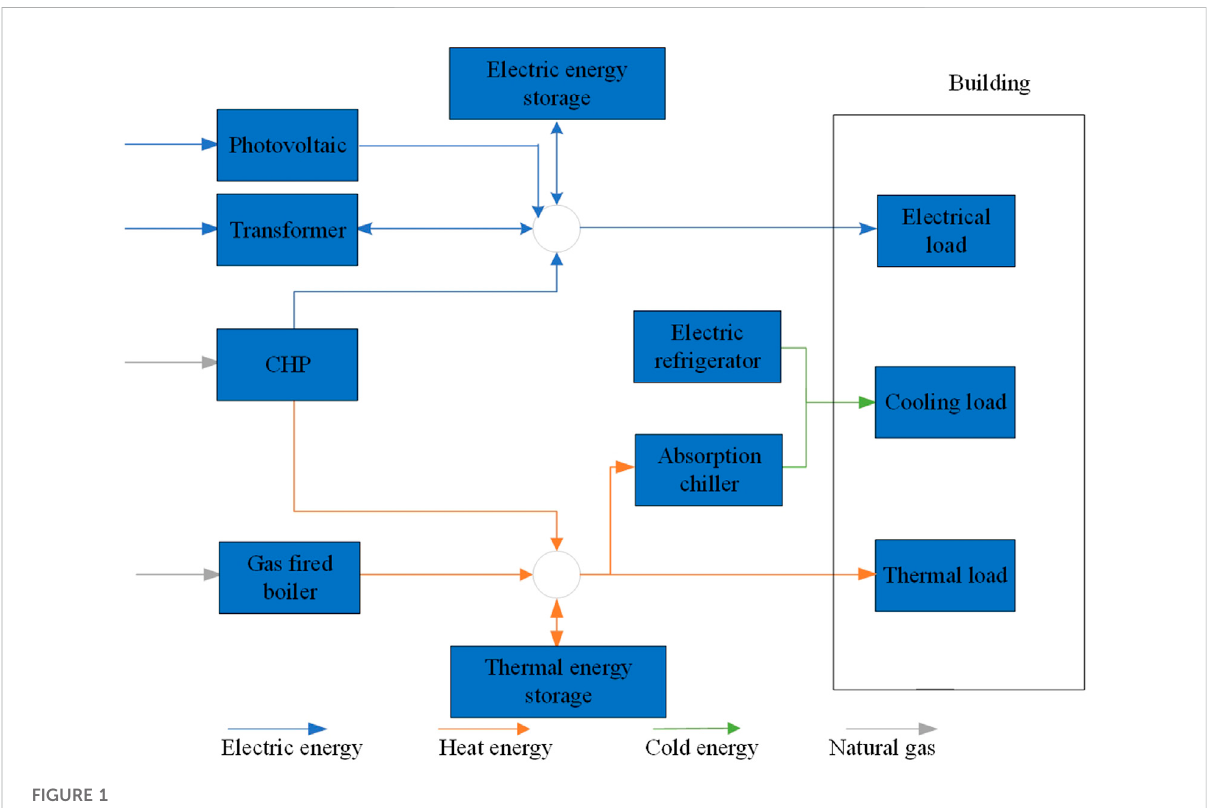
FIGURE 1 Schematic of the building microgrid